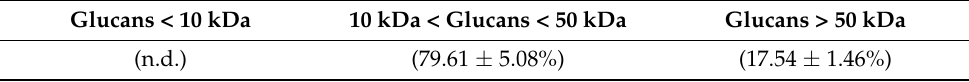
Table 4. Estimation of molecular weight range of glucans in